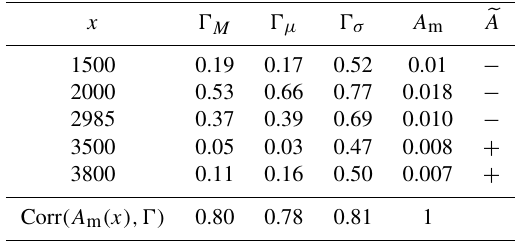
Table 3. Measure of the local coherence of the thunderstorm condi- tion